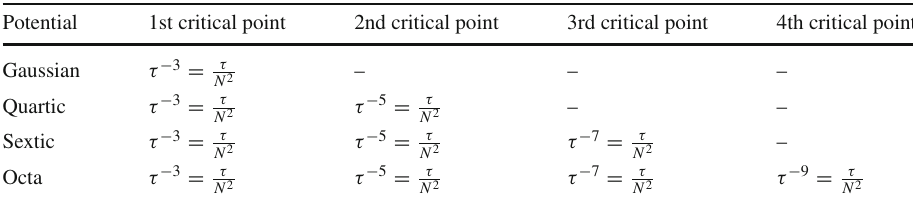
Table 3 Fall-off behaviour near critical points for different even polynomial random potential